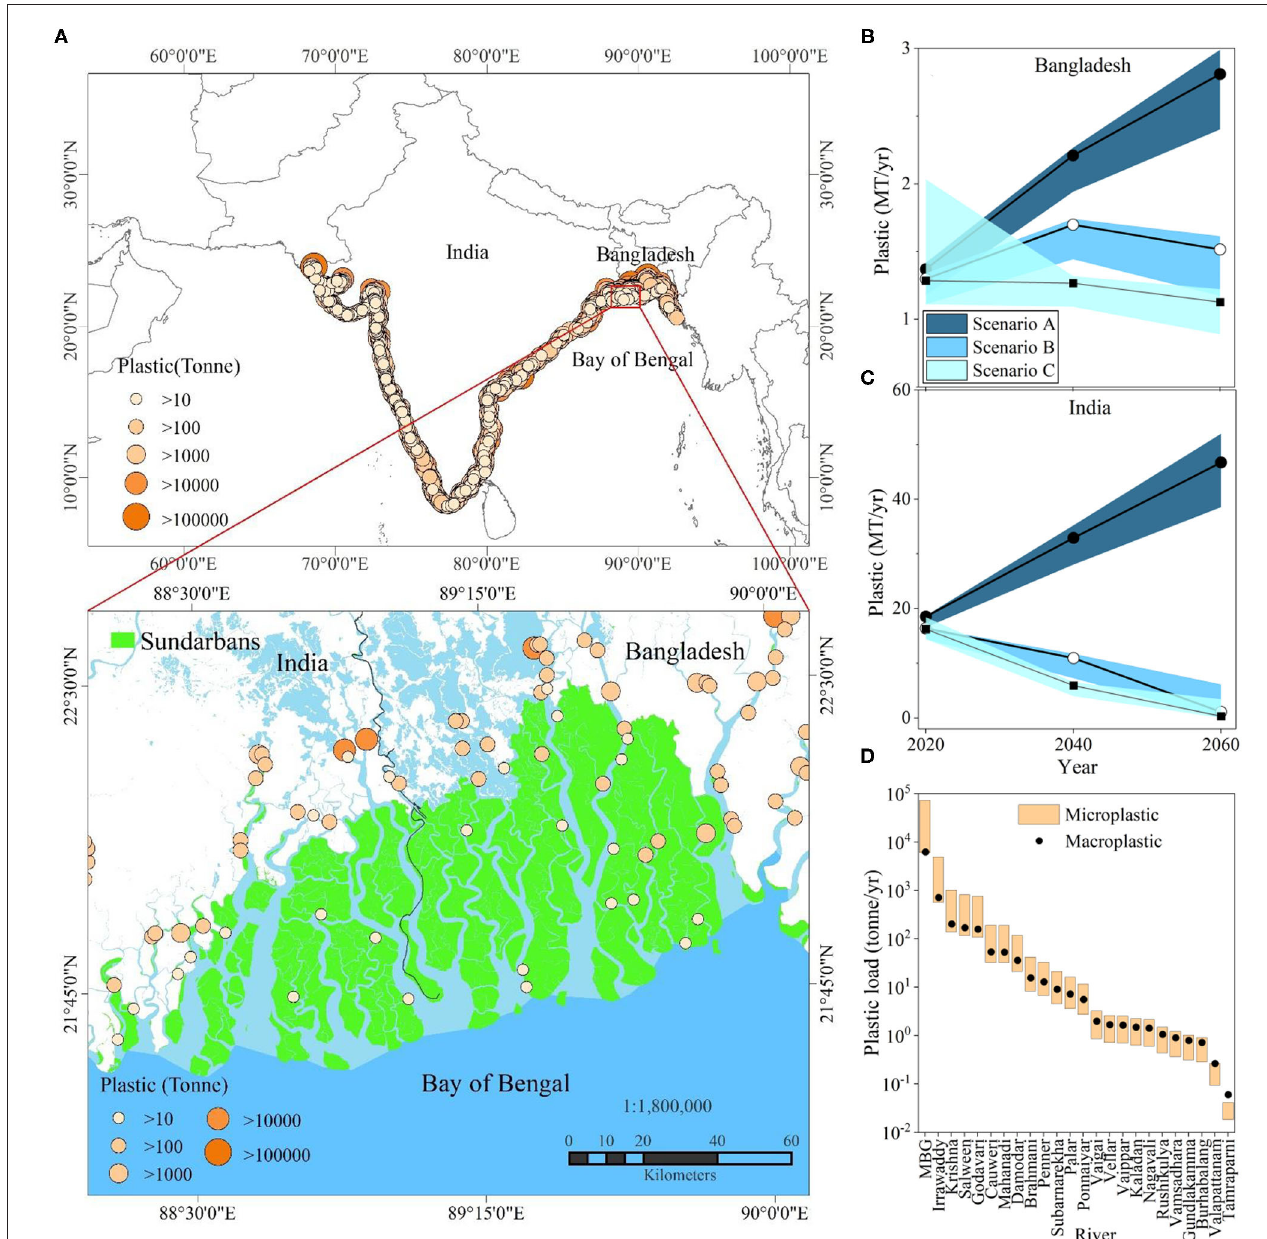
FIGURE 1 | (A) Current status of plastic waste across the coast of India and Bangladesh including the Sundarbans based on Lebreton et al. (2017), (B, C) Possible plastic waste generation in 2020, 2040 and 2060 under three scenarios as per Lebreton and Andrady (2019). Scenario A represents a “business-as-usual” case of 2015 while consumer demand for plastic increases with economy. Scenario B indicates that infrastructures for plastic waste management will advance according to per capita gross domestic product grows. Finally, scenario C corresponds a reduction in plastic demand per capita with fraction of plastic in municipal solid waste capped at 10 and 5% by 2020 and 2040, respectively as well plastic waste management gradually improves as indicated in scenario B. (D) The discharge of plastic waste as microplastic and macro plastic to the Bay of Bengal through different rivers as per 2017. The lower and upper bar indicates microplastics released based on global model based on data of Schmidt et al. (2017). MBG indicates the Meghna, Brahmaputra and Ganges combined.